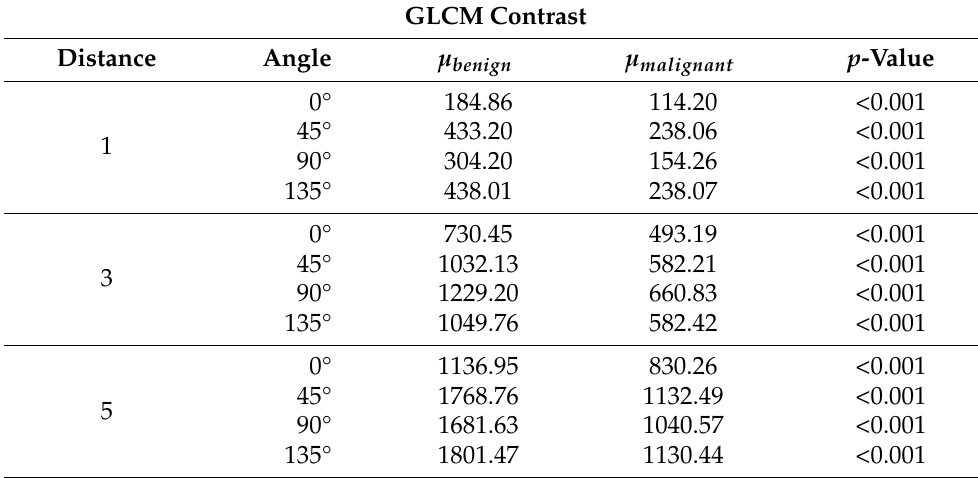
Table A3. The gray level co-occurrence matrix contrast feature measured across three pixel distances